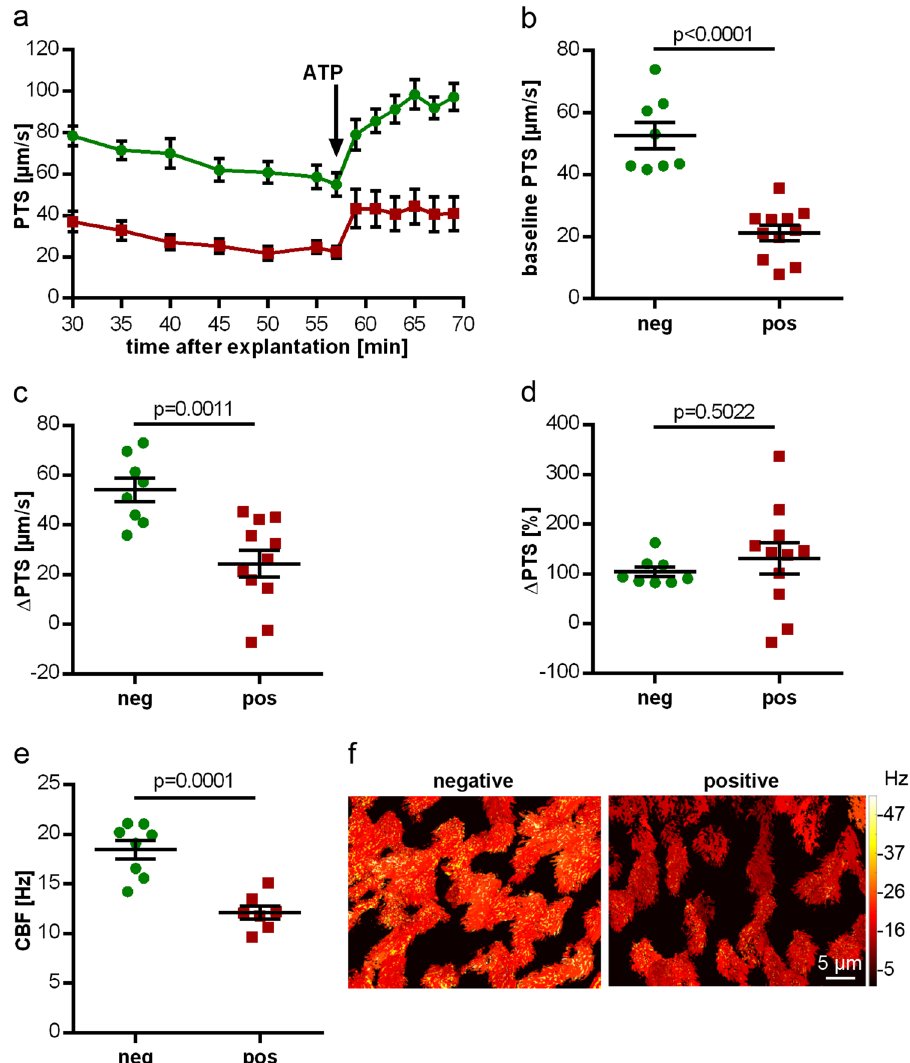
Figure 7. Altered PTS and CBF in B. pseudohinzii- positive animals. ( a ) PTS measurements of mice tested positive (red; n = 11) and negative (green; n = 8) (mean ± SEM) for B. pseudohinzii . In both groups ATP leads to an increase in PTS, but baseline PTS is reduced in B. pseudohinzi -positive animals. ( b–d ) Statistical analysis of the experimental setup shown in ( a) . Individual data points with mean ± SEM are shown. ( b ) Baseline PTS of B. pseudohinzii- positive animals is significantly lower compared to negatively tested animals. ( c ) Absolute increase in PTS after 8 min of ATP application is significantly lower in B. pseudohinzii -positive animals. ( d ) ATP-driven increase, expressed in percentage relative to baseline, is not different between the groups. ( e ) Baseline CBF of B. pseudohinzii -positive animals is significantly decreased 27 min after explantation of the trachea. Individual data points and mean ± SEM are shown. B. pseudohinzii -positive animals (red; n = 7) and B. pseudohinzii- negative animals (green; n = 8). The microscopic images show the mucosal surface with false colour coding of CBF of single ciliated cells; brighter colours represent higher CBF. Decrease in CBF in B. pseudohinzii -positive animals is a general feature of the majority of ciliated cells and is not restricted to single ciliated cells. All p-values were calculated by Student’s unpaired